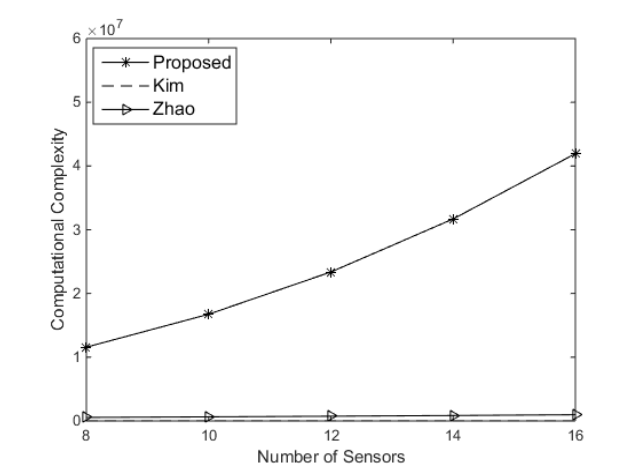
Figure 2. Complexity comparison of different approaches versus the number of